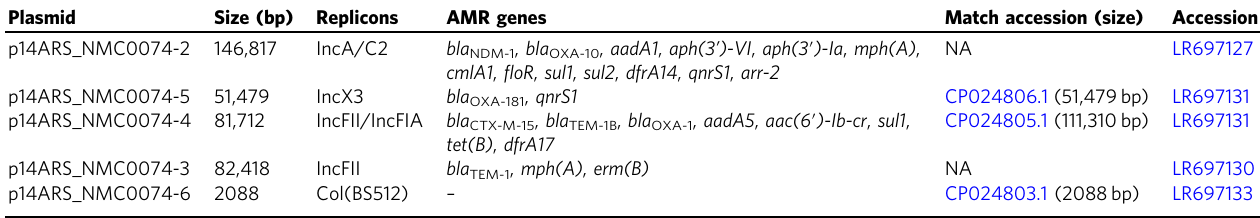
Table 4 Plasmid repertoire of carbapenem-resistant E. coli strain 14ARS_NMC0074.